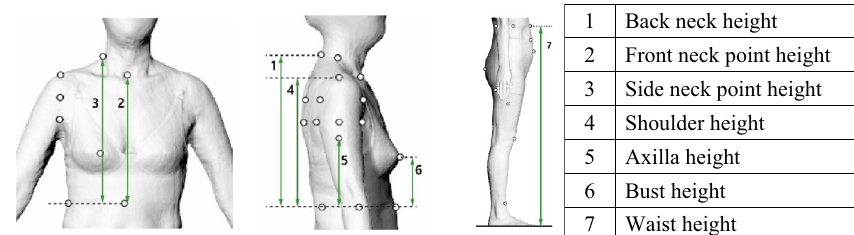
Table 4 Measurement